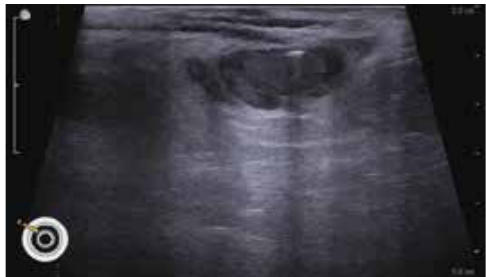
Figure 8 Ultrasound image from video capture on a sagittal view at 9~10 o’clock identified the chicken bone as a hyperechoic line with an acoustic shadow, which mistaken as a gas bubble within the abscess.